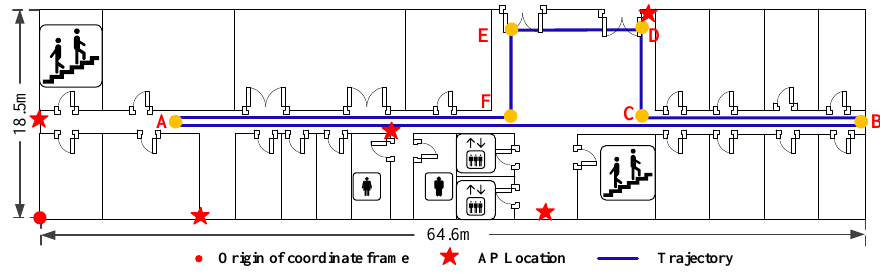
Figure 13. Testbed for heading estimation.